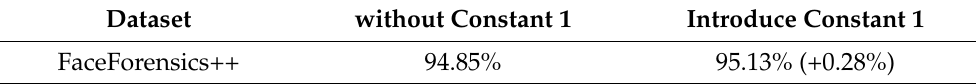
Table 8. Comparison of accuracy of whether to introduce the constant 1 in the SMFAN